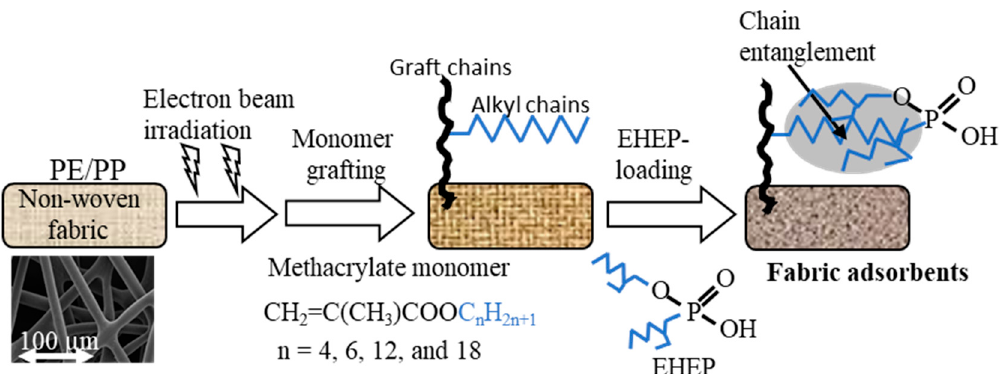
Figure 1. Preparation of the fabric adsorbents by graft polymerization of methacrylate monomers and